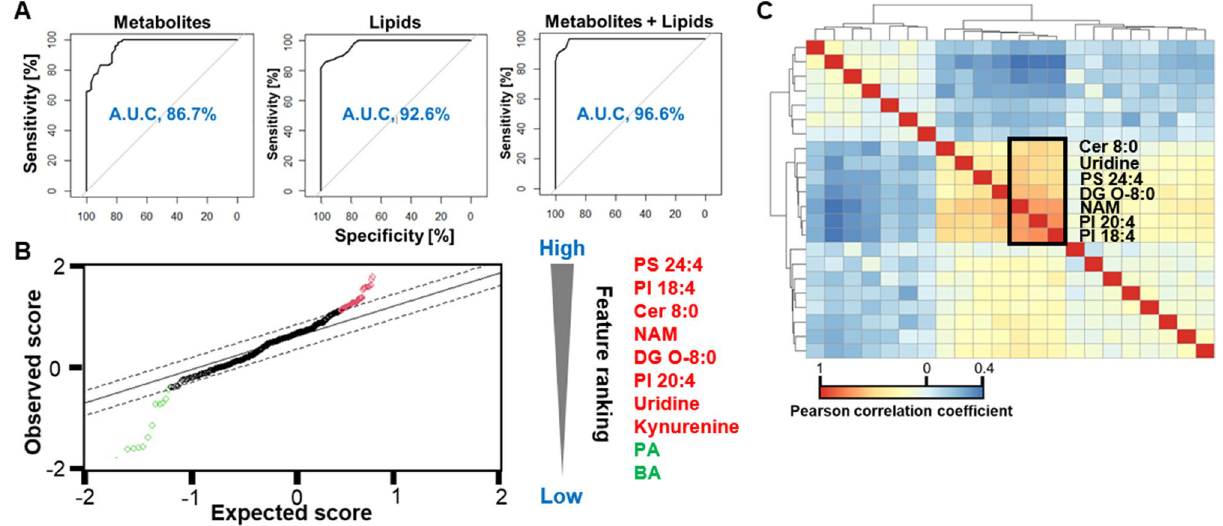
Figure 8. Significance analysis of metabolites and lipids differentiating GXP-negative and GXP-positive groups. ( A ) AUC values for logistic regression models using identified molecules. ( B ) Feature ranking analysis of metabolites and lipids based on significance analysis of microarrays (SAM) algorithm. ( C ) Correlation heatmap of metabolites and lipids based on Pearson correlation coefficient analysis. Red dots indicate increasing and green dots indicate decreasing in